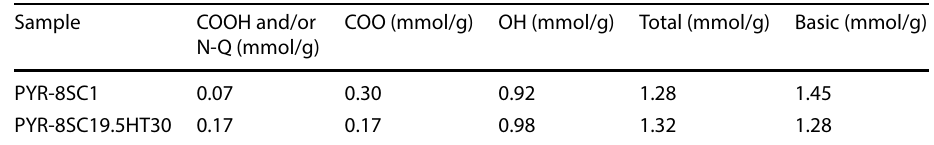
Table 4 Surface oxides on carbon of ACF by Boehm titration